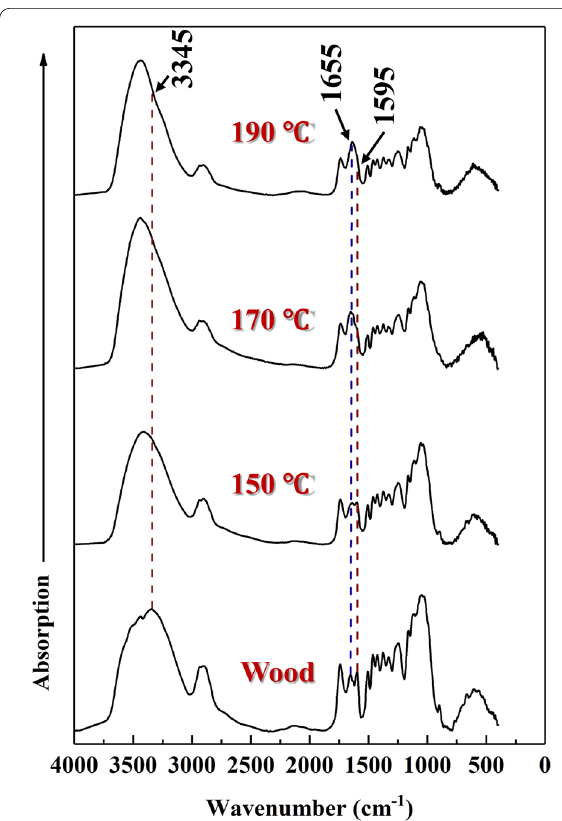
Fig. 9 FT-IR spectra of the insoluble mass obtained from EHADP adhesive which heated at different